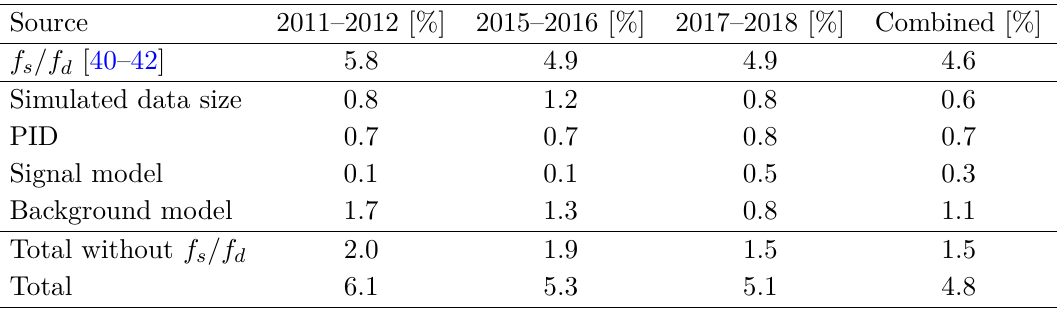
Table 1 . Systematic uncertainties on B ( B 0 uncertainty is given relative to the measured